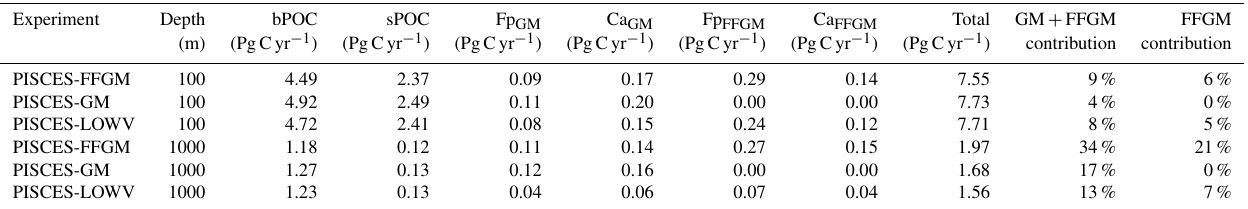
Table 5. Particulate carbon flux composition at 100 and 1000m. Units are in PgCyr − 1 . sPOC (resp. bPOC) is for small (resp. large) particulate organic carbon. Ca GM (resp. Ca FFGM ) is for GM (resp. FFGM) carcasses. Fp GM (resp. Fp FFGM ) is for GM (resp. FFGM) fecal